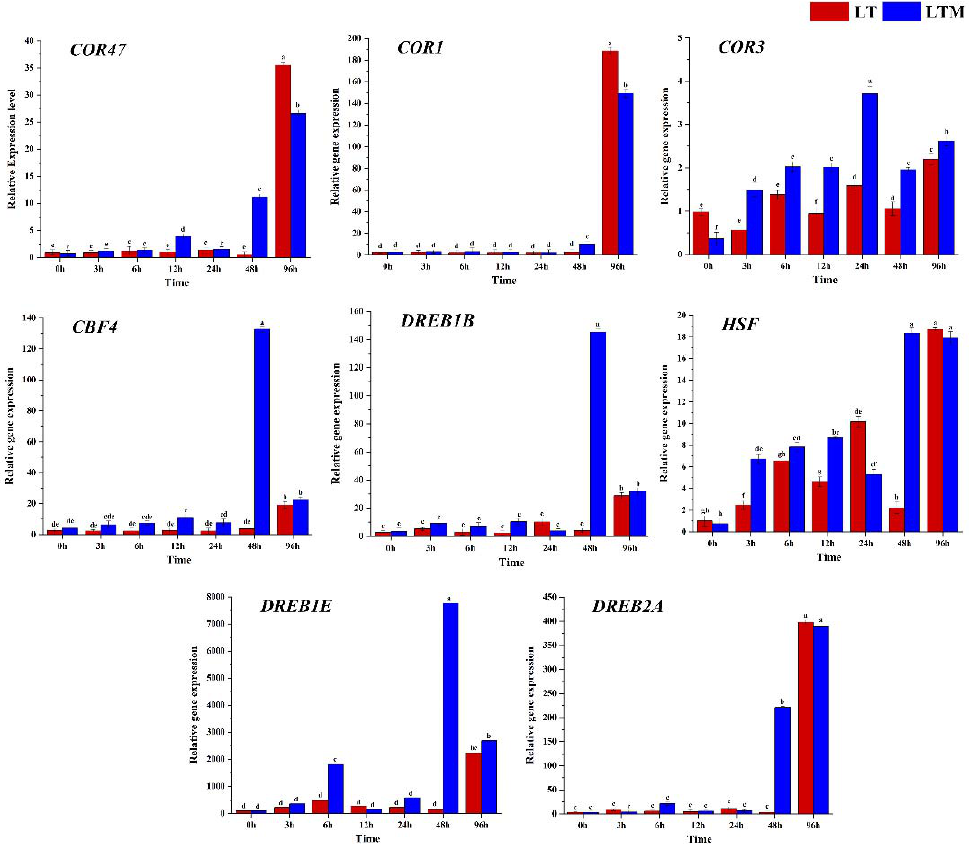
Figure 5. Expression of cold-related genes in leaves of strawberry under cold stress. The strawberry seedlings were pretreated with distilled water (LT) or 100 µ M melatonin (LTM) 3 times in a two-day interval and then exposed to cold stress for 2 days. Samples were taken at 0, 3, 6, 12, 24, 48, and 96 h after cold treatment. Graphs represent the mean of three biological replicates. Values labeled with different letters indicate significant differences among treatments at ( p ≤ 0.05) by LSD.